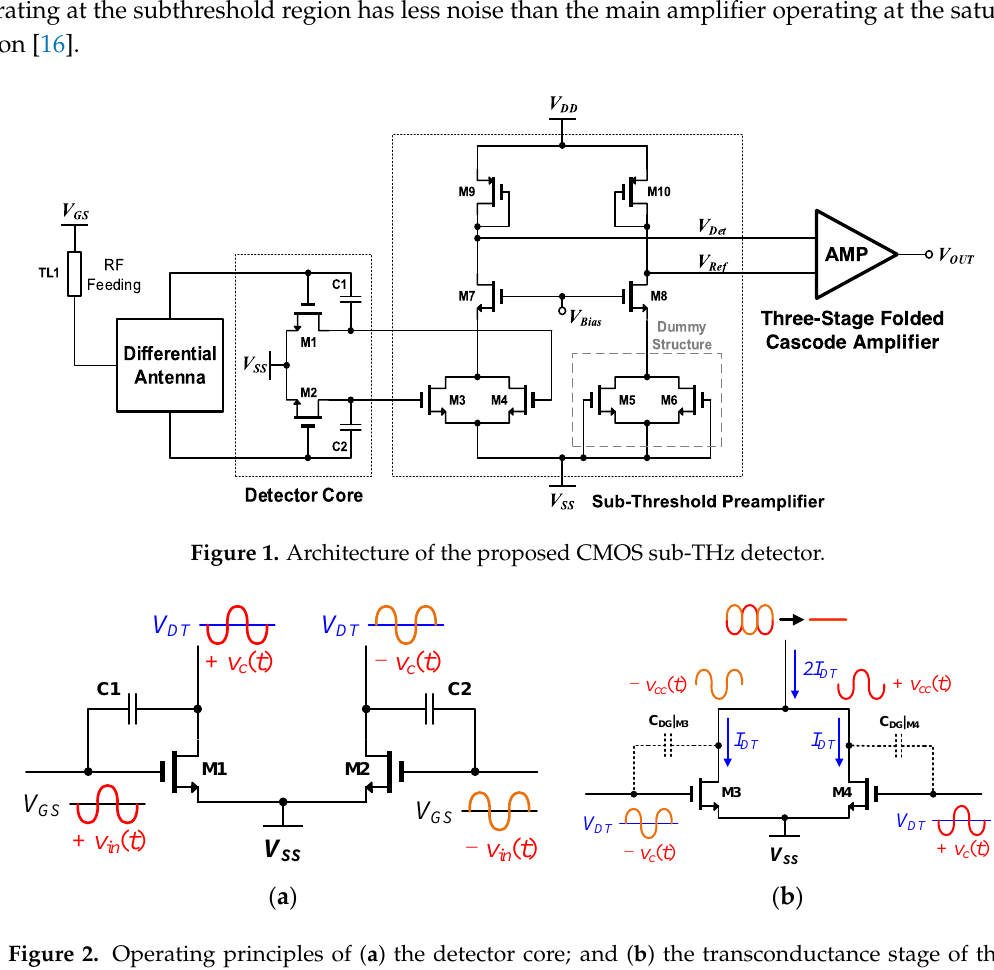
Figure 2. Operating principles of ( a ) the detector core; and ( b ) the transconductance stage of the subthreshold preamplifier in the proposed CMOS sub-THz detector.